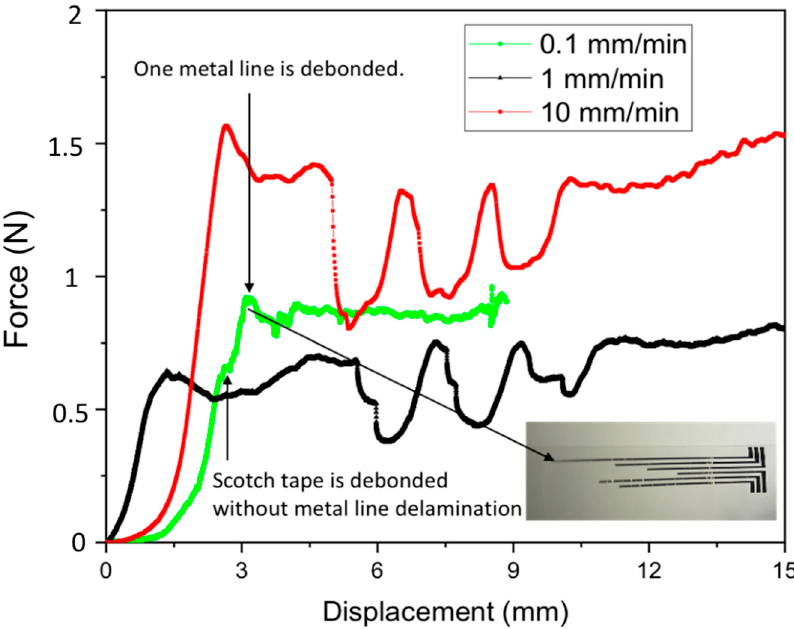
Figure 7. Force-displacement curves from scotch tape test with metal lines on parylene substrate with CF 4 treatment.